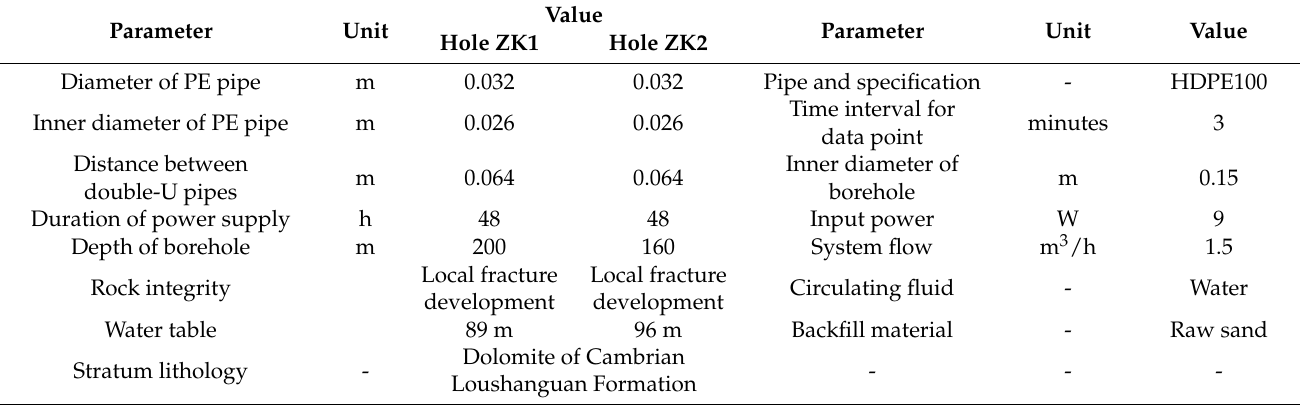
Figure 1. Working area location and test diagram. Table 1. The parameters of thermal response test.